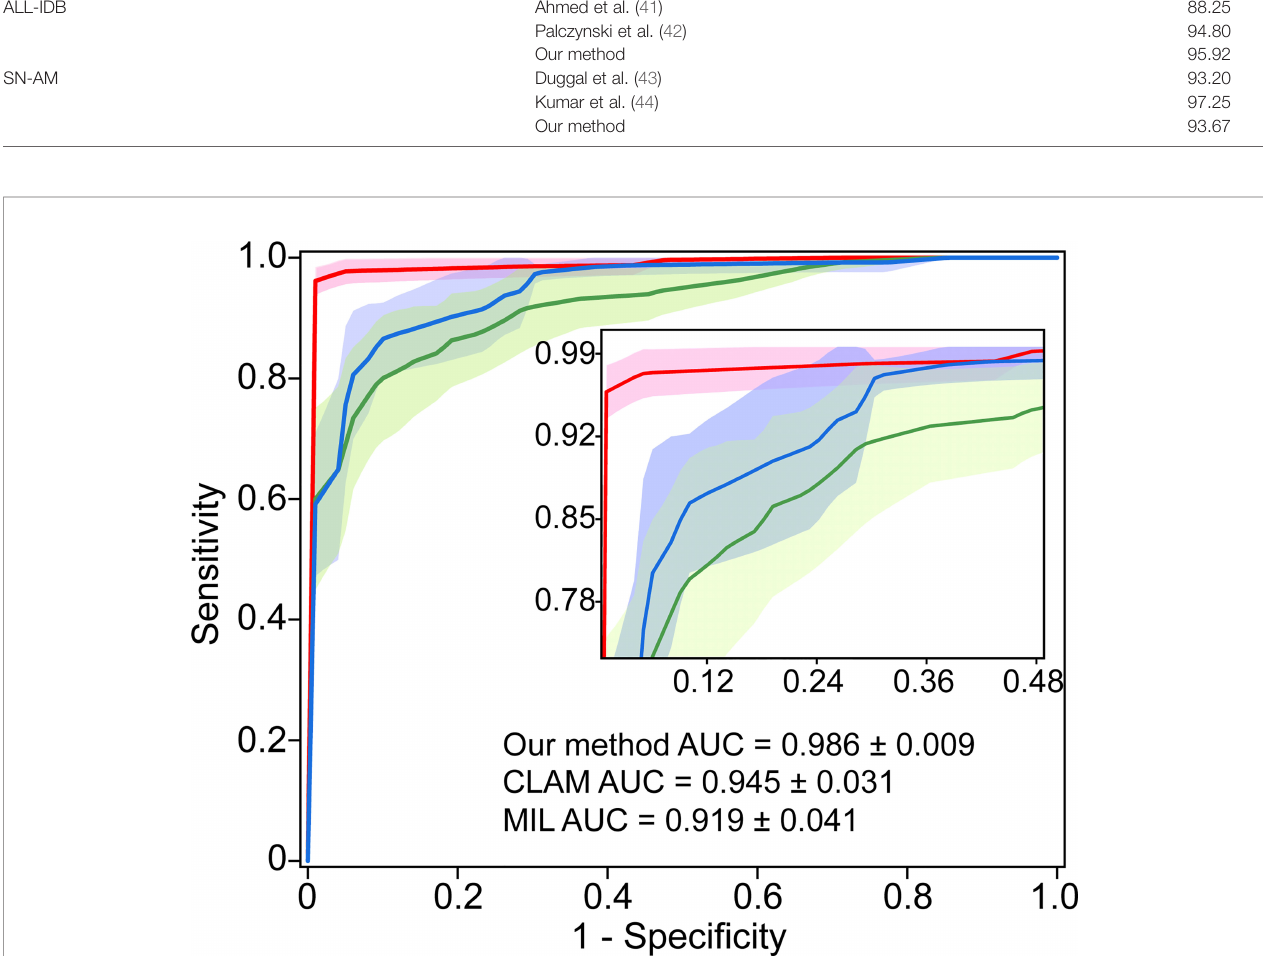
FIGURE 6 | Comparison with the state-of-the-art methods. 5-fold mean test macro-averaged AUC ± s.d. of our model compared with CLAM and